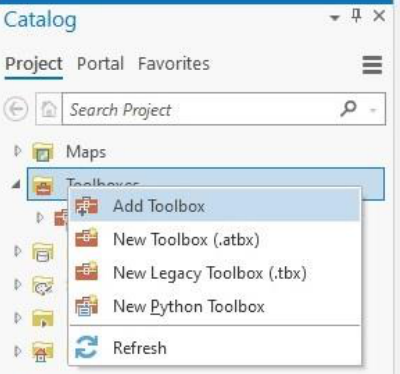
Figure A2. Adding the Water Yield Estimation toolbox to the project toolboxes folder.